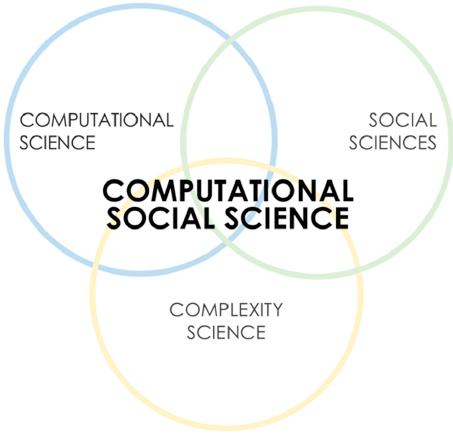
Figure 2. Computational social science: scientific background (source: adapted from ref.[11]).